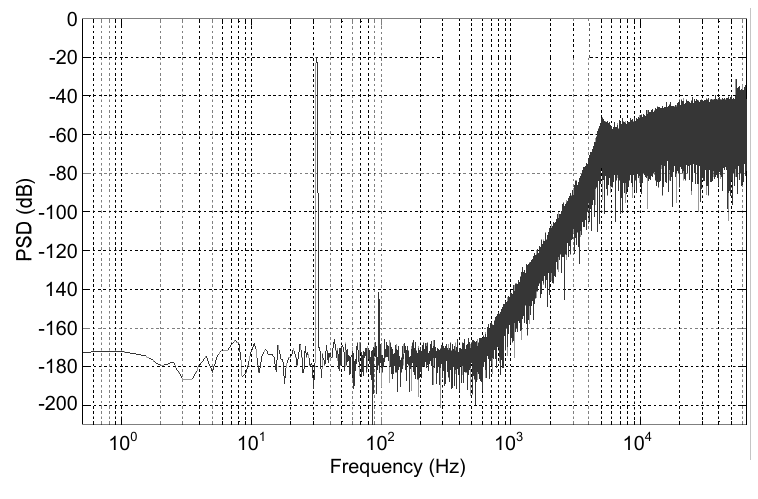
Figure 6. Power spectral density of the individual chosen as final